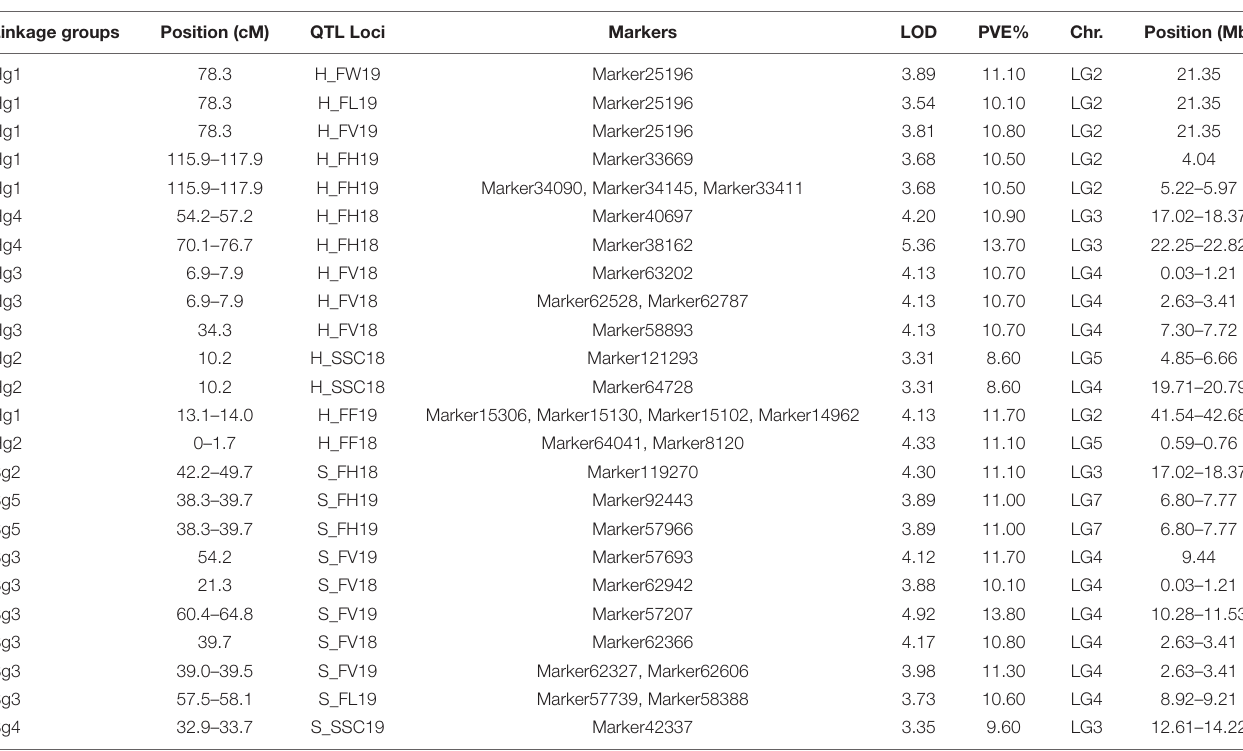
FIGURE 3 | QTLs of fruit quality traits located on “H” and “S” by multiple-QTL-mapping (MQM). QTLs are represented by black bars positioned at the right of each linkage group. QTLs of different trait are drawn by Mapchart software with different RGB colors. TABLE 4 | The significant QTLs and regions in reference